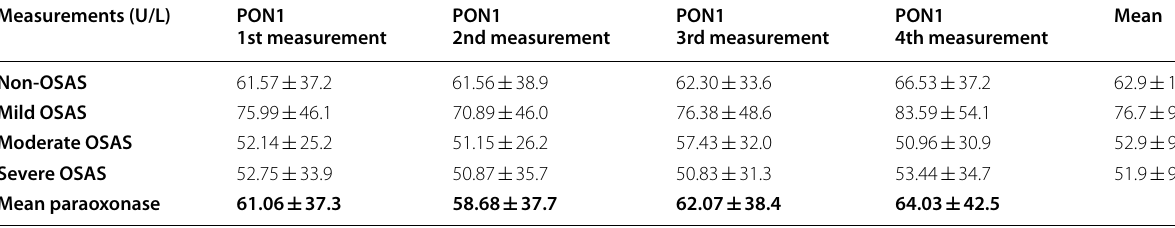
Table 6 Comparison of paraoxonase measurements between the